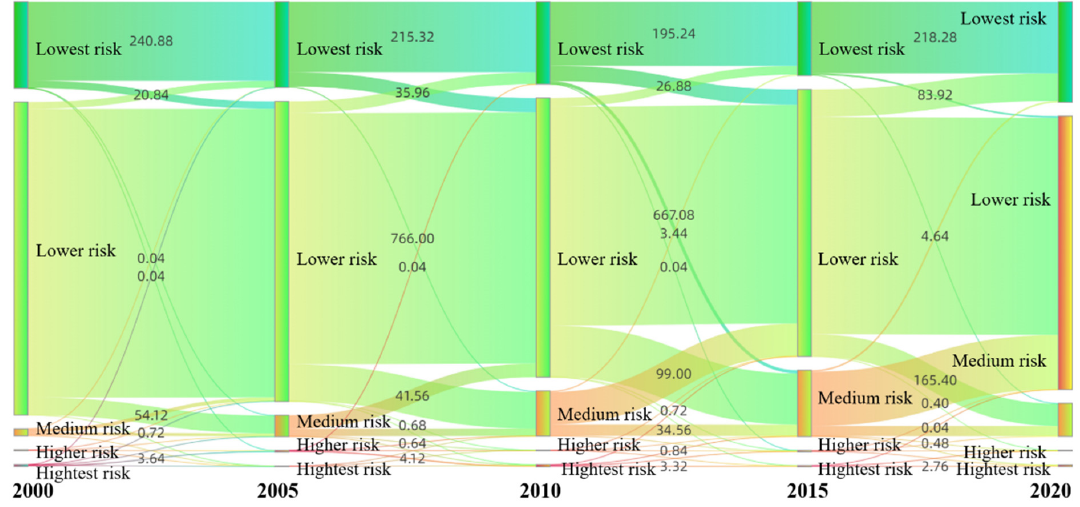
Figure 8. Ecological risk transfer in Zhangjiachuan County from 2000 to 2020 (km 2 ).